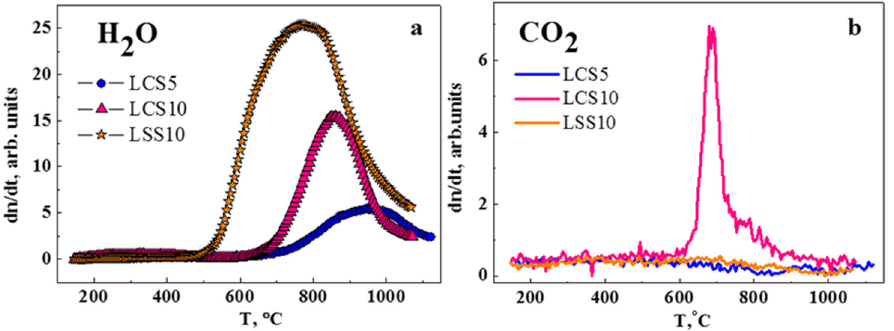
Figure 4. TDS results for LCS5, LCS10 and LSS10 ceramic samples: ( a ) Release of H 2 O; ( b ) release of CO 2 .